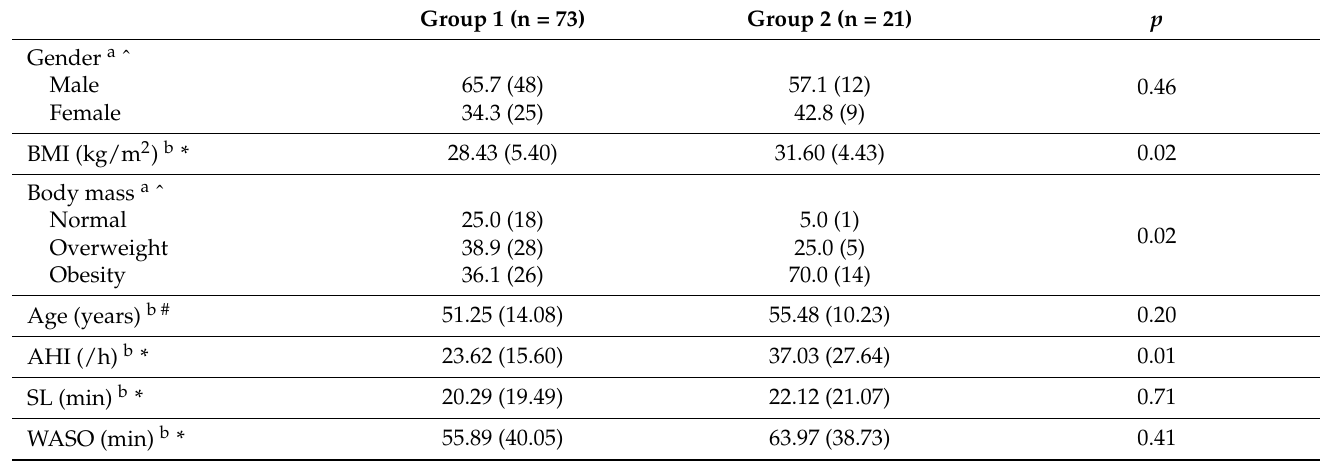
Table 1. Quantitative comparison of the parameters in groups 1 (meeting the criteria for body position-related OSA) and 2 (not meeting the criteria for body position-related OSA—control